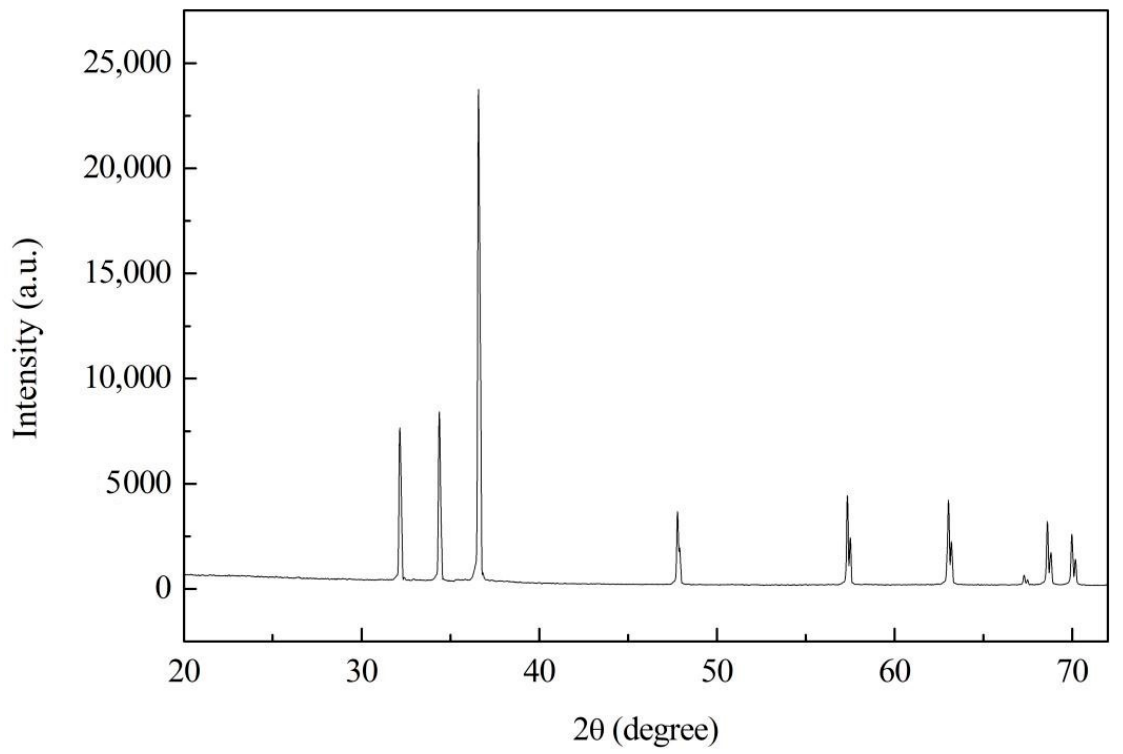
Figure 2. XRD pattern of Mg